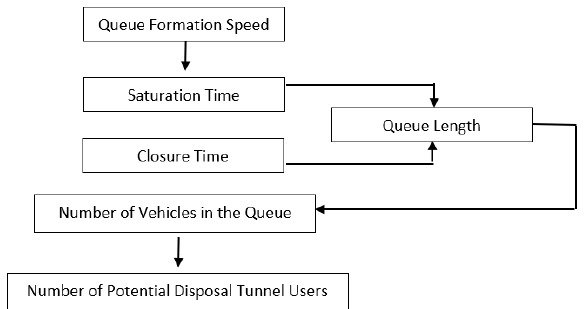
Figure 1. The process sequence of calculating the number of people in the queue.